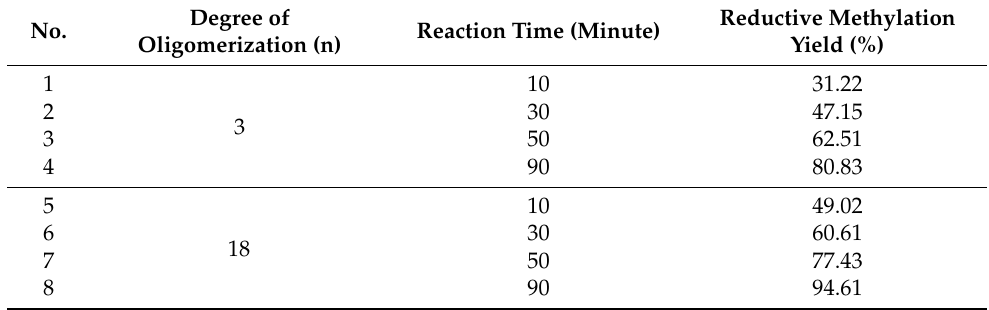
Table 2. The dependence of the reductive methylation yield of LM(EO) 3;18 AP on the reaction time, molar ratio formic aldehyde/LM(EO) 3;18 AP 1.3/1, molar ratio formic acid/LM(EO) 3;18 AP 5/1, and temperature 70 ◦ C.